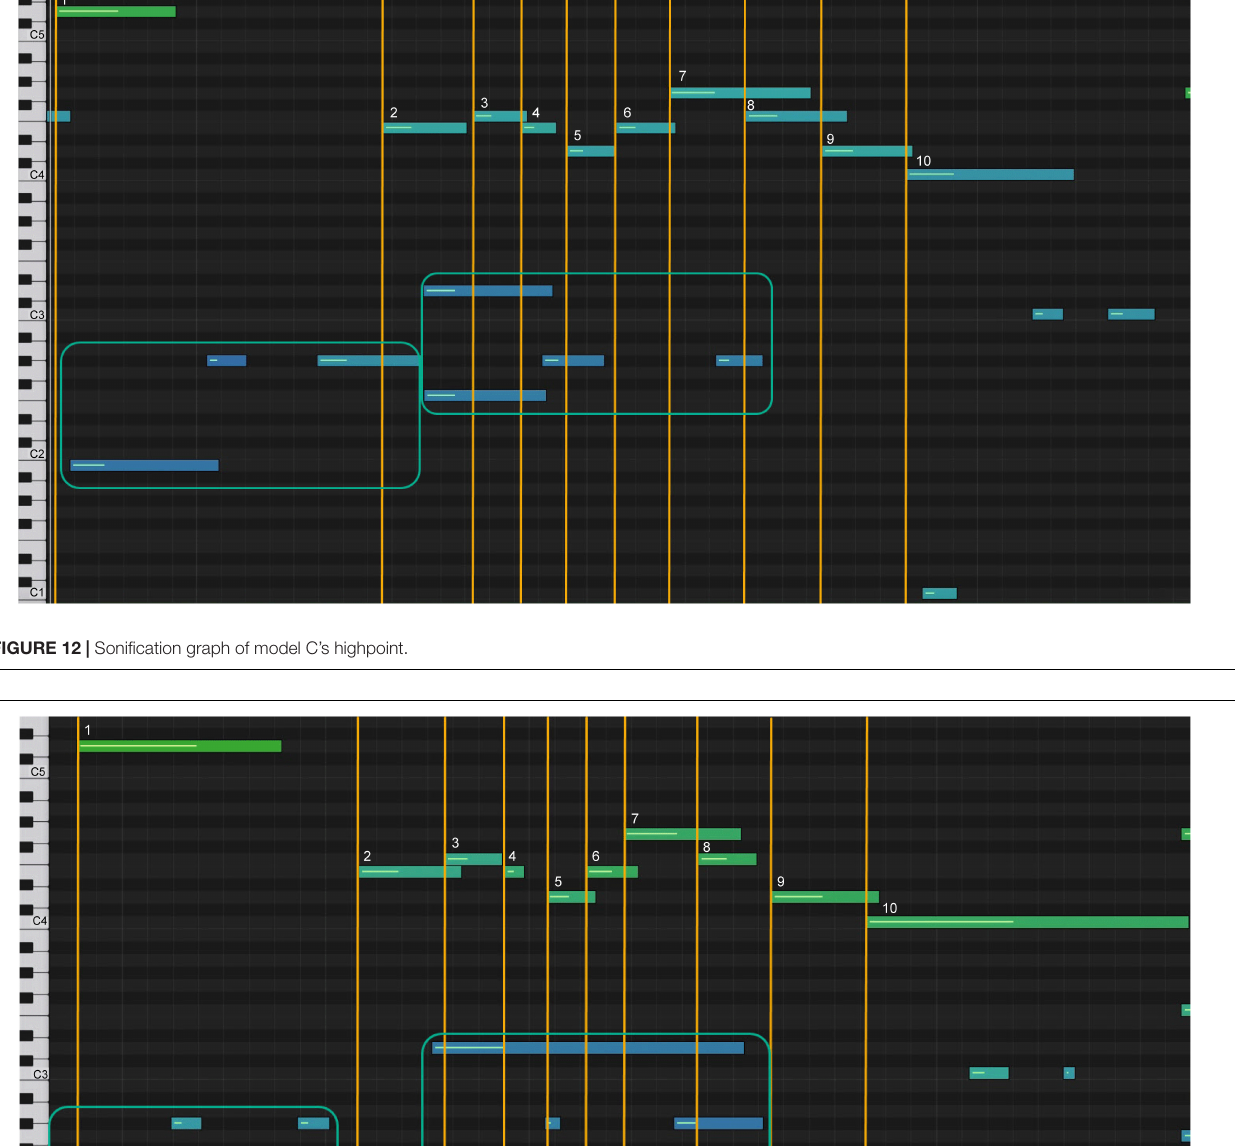
The spacing between the note bars of the melody and the accompaniment is marked by the yellow lines, and the lengthening of the intervals between notes 7, 8, and 9